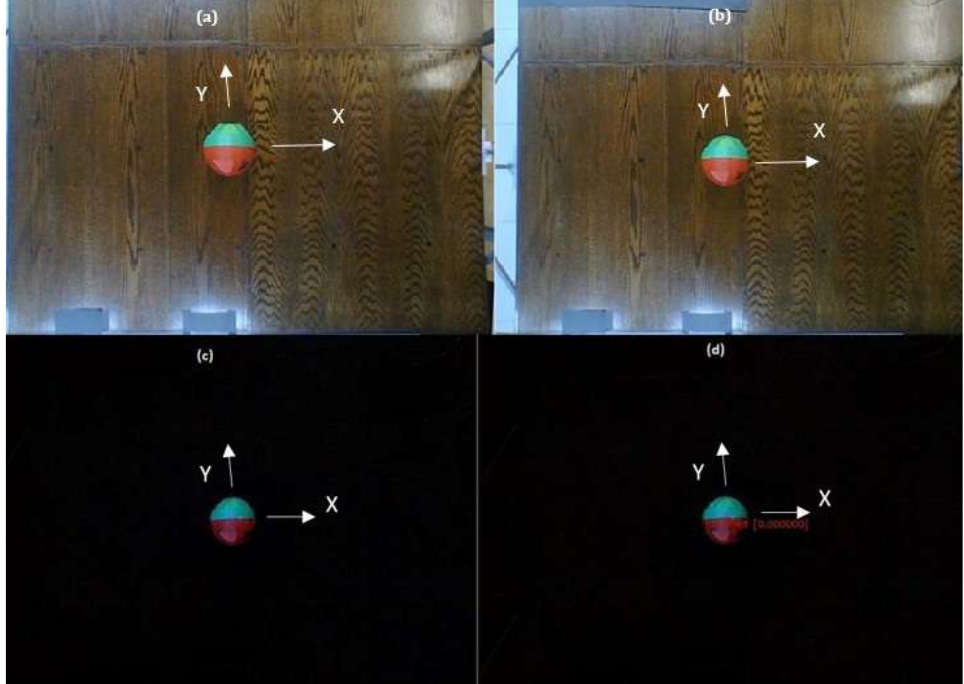
Figure 6. Switrack configuration: ( a ) Input from USB Camera. ( b ) Convert to colour. ( c ) Adaptive Background. ( d ) Red- Green Marker